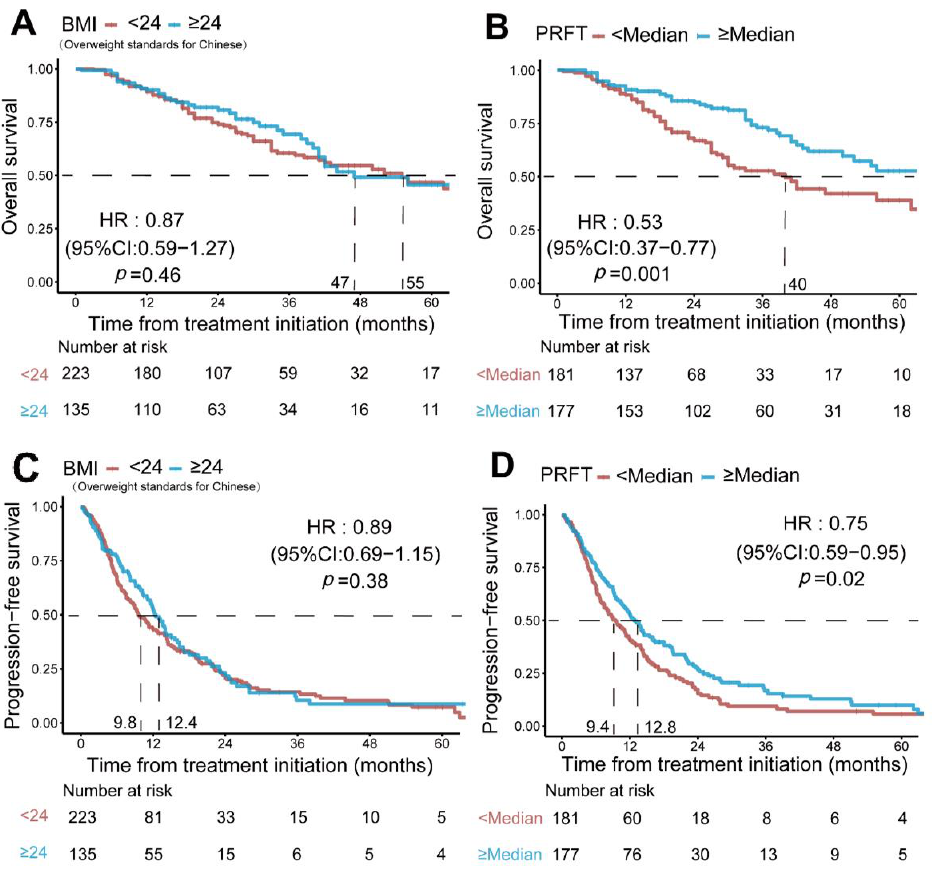
Figure 1. Log-rank survival analysis of different BMI and PRFT in 358 patients treated with target therapy. BMI was not a significant predictor in either OS ( A ) or PFS ( D ). While patients can be well grouped into different prognostic risk groups according to different PRFT ( B , C ). BMI: body mass index; PRFT: perirenal fat thickness; OS: overall survival. PFS: progression-free